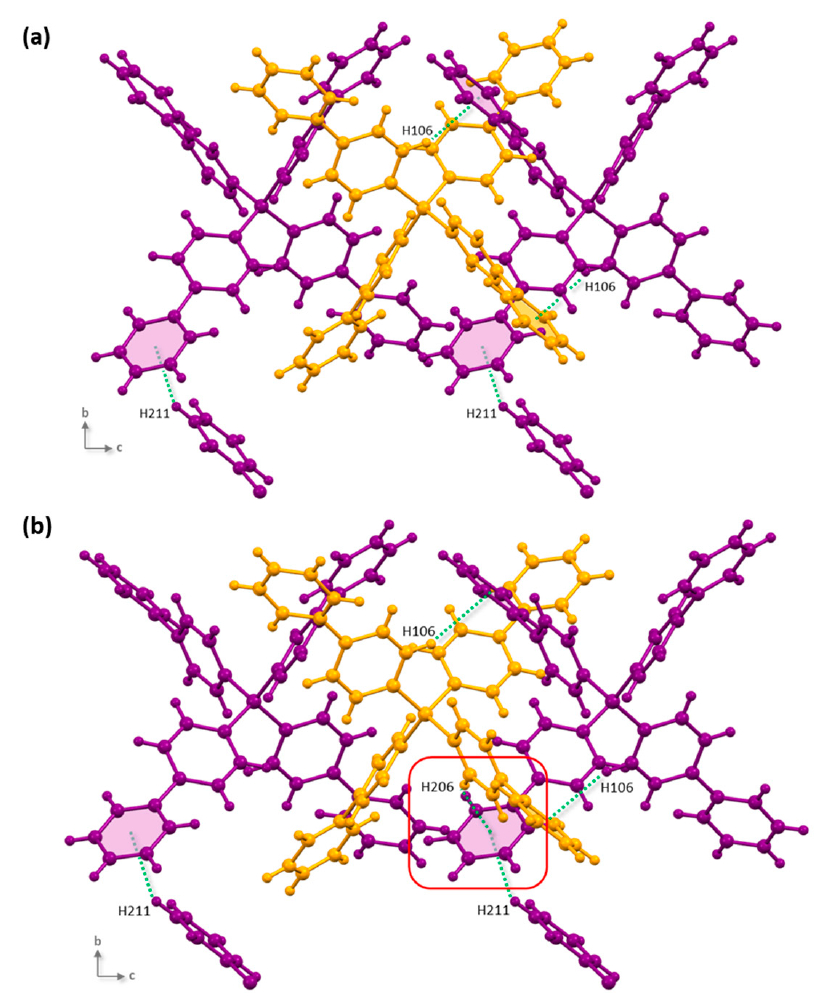
Figure 3. Ball-and-stick representation of C–H ··· π interactions between phosphonium cations in 1 ( a ) and 2 ( b ), with the red square highlighting an additional crystallographically unique C–H ··· π interaction found in 2 .